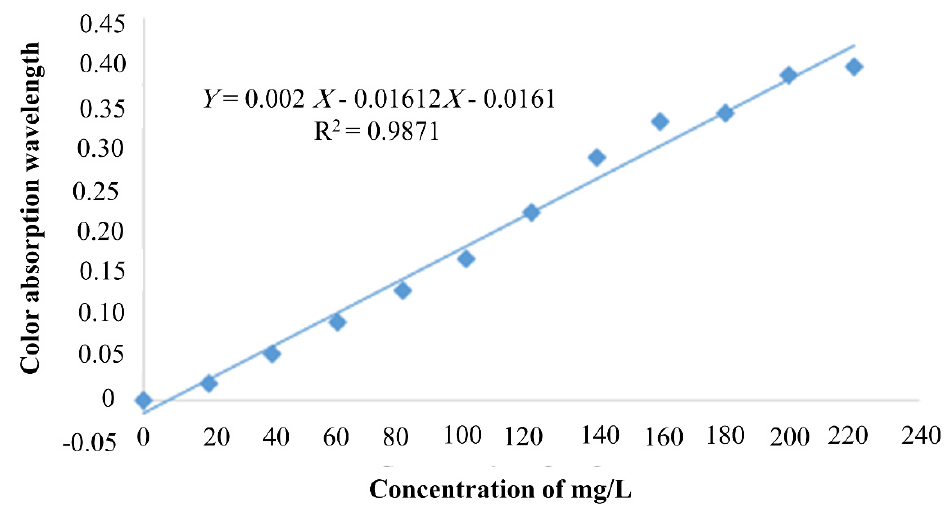
Figure 7. Standard absorption curve of different concentrations of standard galic acid solution.